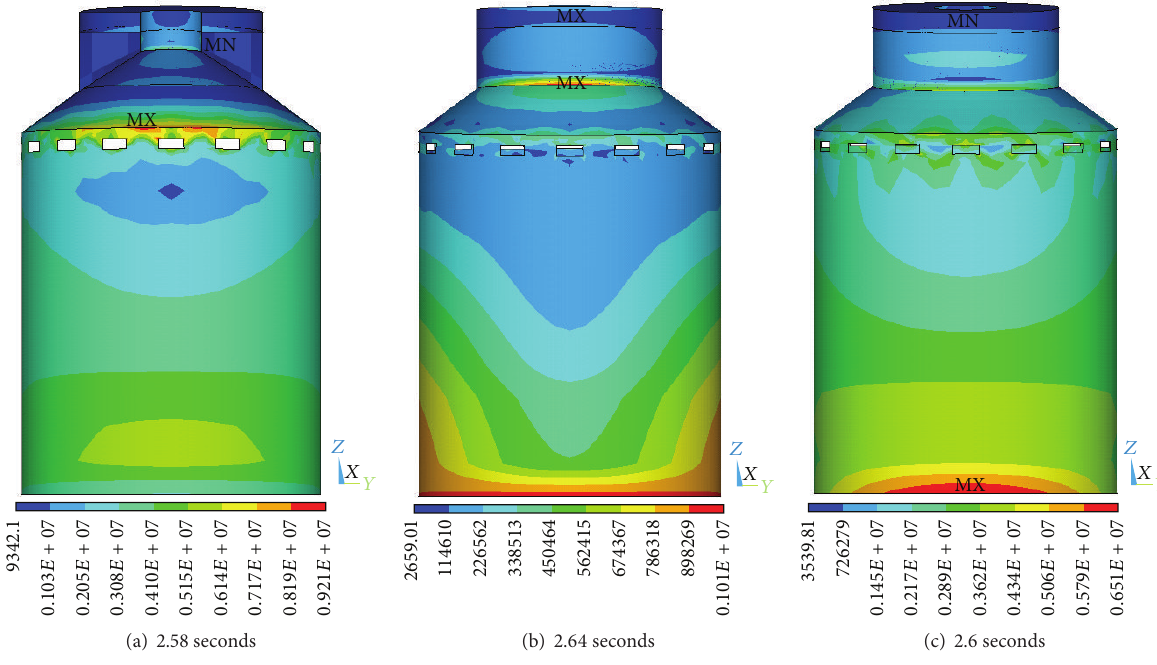
Figure 6: The von Mises stress distribution of shield building of Case I.